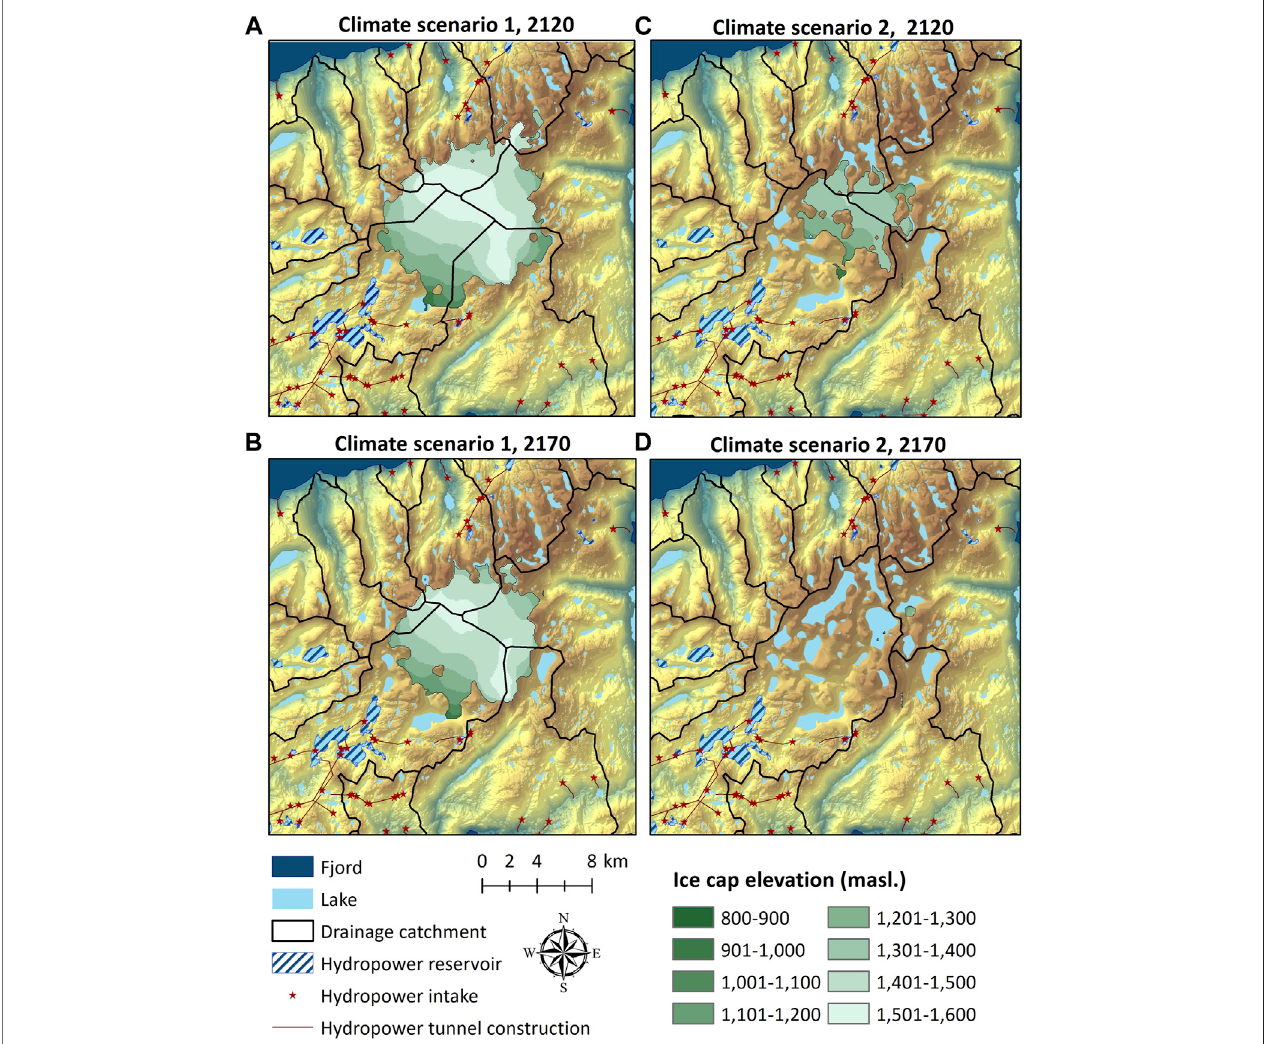
FIGURE 8 | (A,B) Model results implementing climate scenario 1 (1.5 ° C increase), 100 and 150 years in the future. The northern part of the glacier is sensitive and retreatsbefore2120,butthesouthernpartoftheglacierismoreresilient. (C,D) Modelresultsimplementingclimatescenario2(3.5 ° Cincrease),100and150 yearsinthe future. The glacier retreats faster than in scenario 1. However, even when most of the ice cap is gone in 2120, the drainage basins still have northerly and southerly drainage.